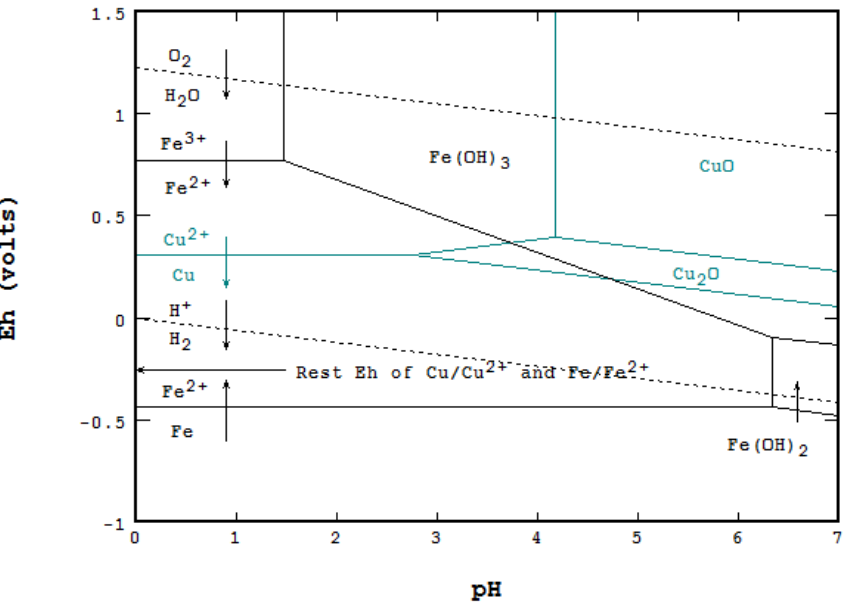
Figure 20. Combined Cu and Fe Eh-pH diagrams would show that reactions occur during copper cementation using metallic iron.